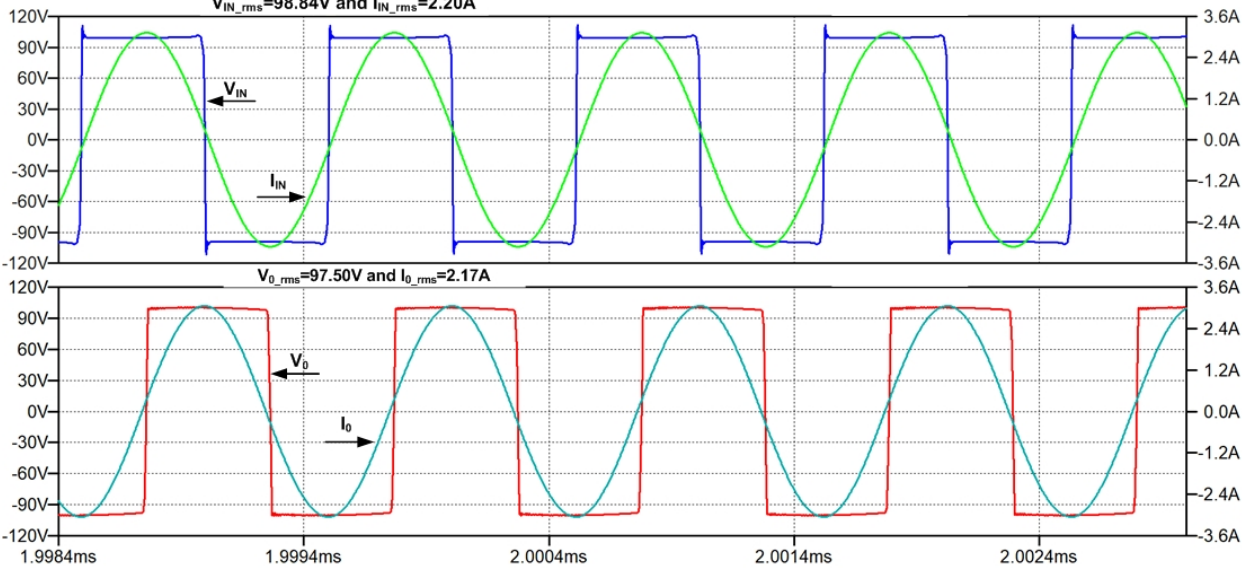
Figure 18. Input voltage (blue), output voltage (red), input current (green), and output current (blue), P o = 200 W. P o = 200